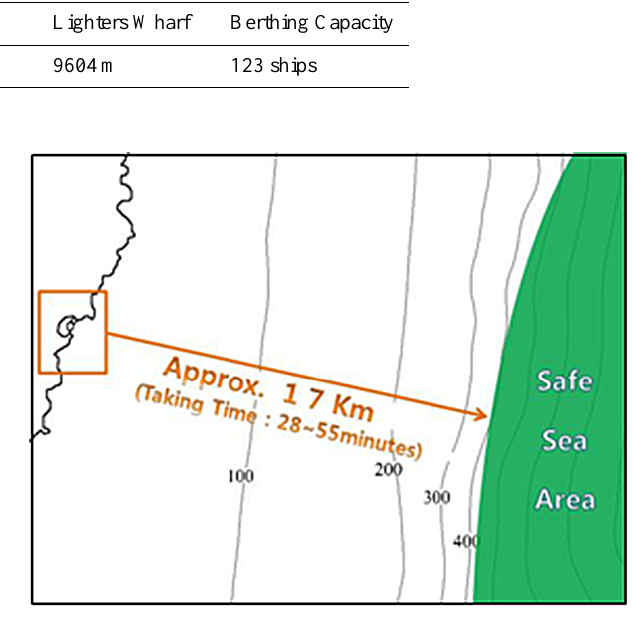
Figure 4. Distance to safe sea area at Guryongpo